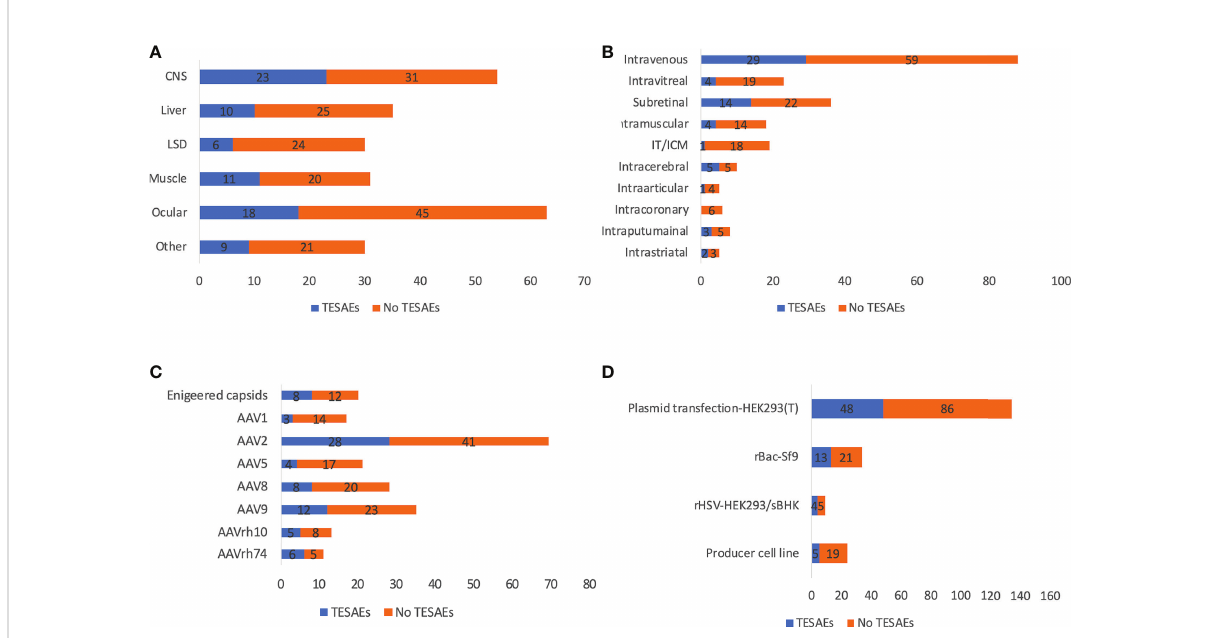
FIGURE 4 Reported TESAEs of 255 AAV clinical trials by disease indications (A) , ROAs (B) , serotypes (C) , and manufacturing systems (D) . ROA and serotypes associated with <10 trials are not included in the fi gure. IT and ICM were combined due to the high similarity. Trials that initiated recently are not included for